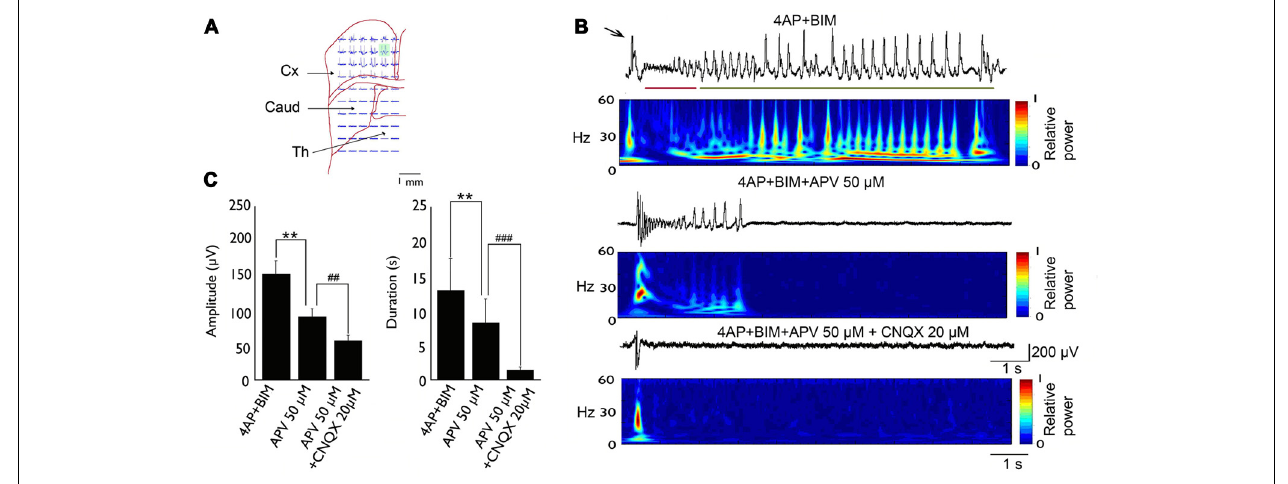
FIGURE 1 |Typical example of 4-AP + bicuculline-induced epileptiform activity in an MT-ACC slice. (A) Location of the multielectrode and brain slice. The green area is selected and magnified in (B) . (B) Epileptiform activity is composed of ictal discharges (arrow), tonic-phase firing (red line), and clonic-phase firing (green line). The application of APV (50 μ M) decreased the amplitude and duration of clonic-phase firing, and the subsequent application of CNQX (20 μ M) completely abolished